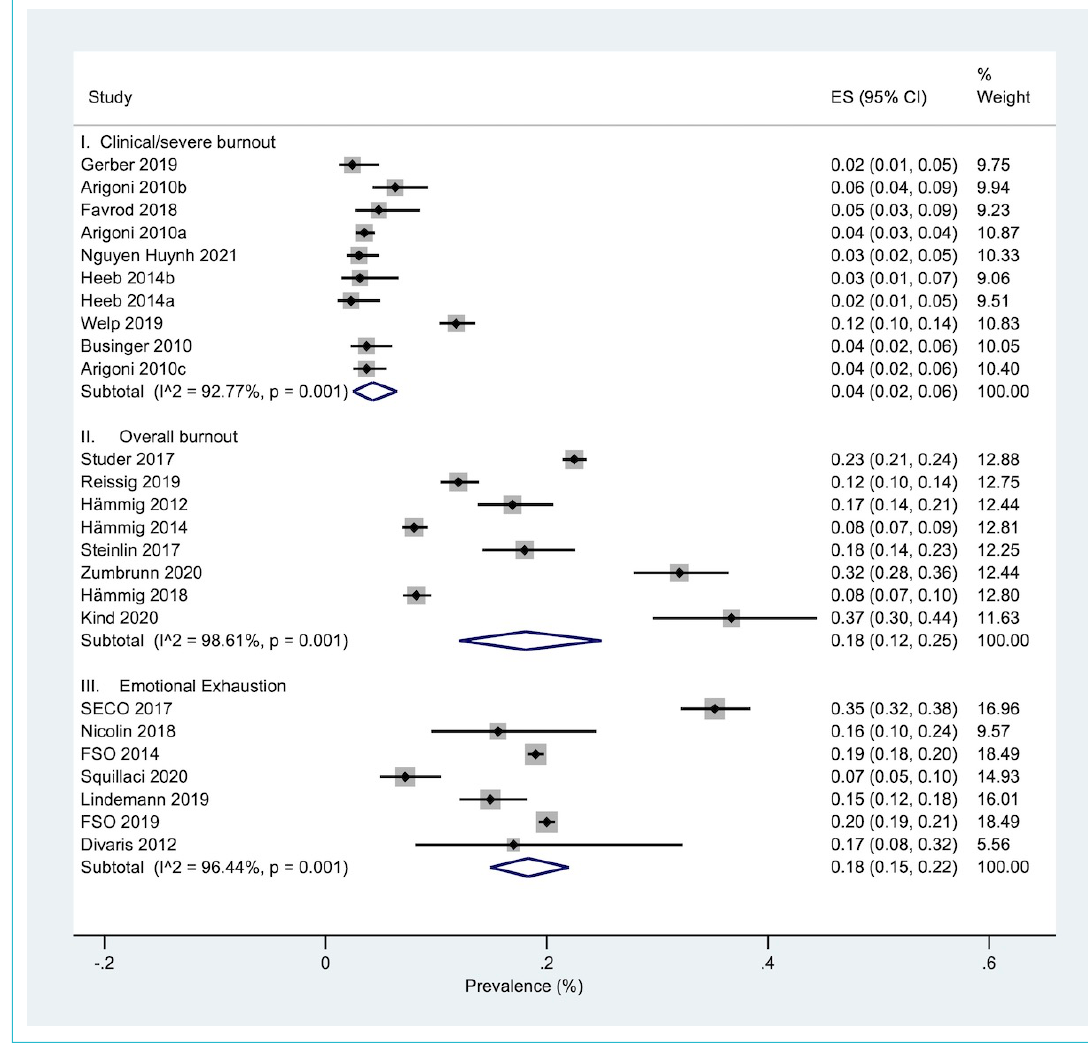
Figure 2: Prevalence of burnout stratified by burnout ouctomes in any